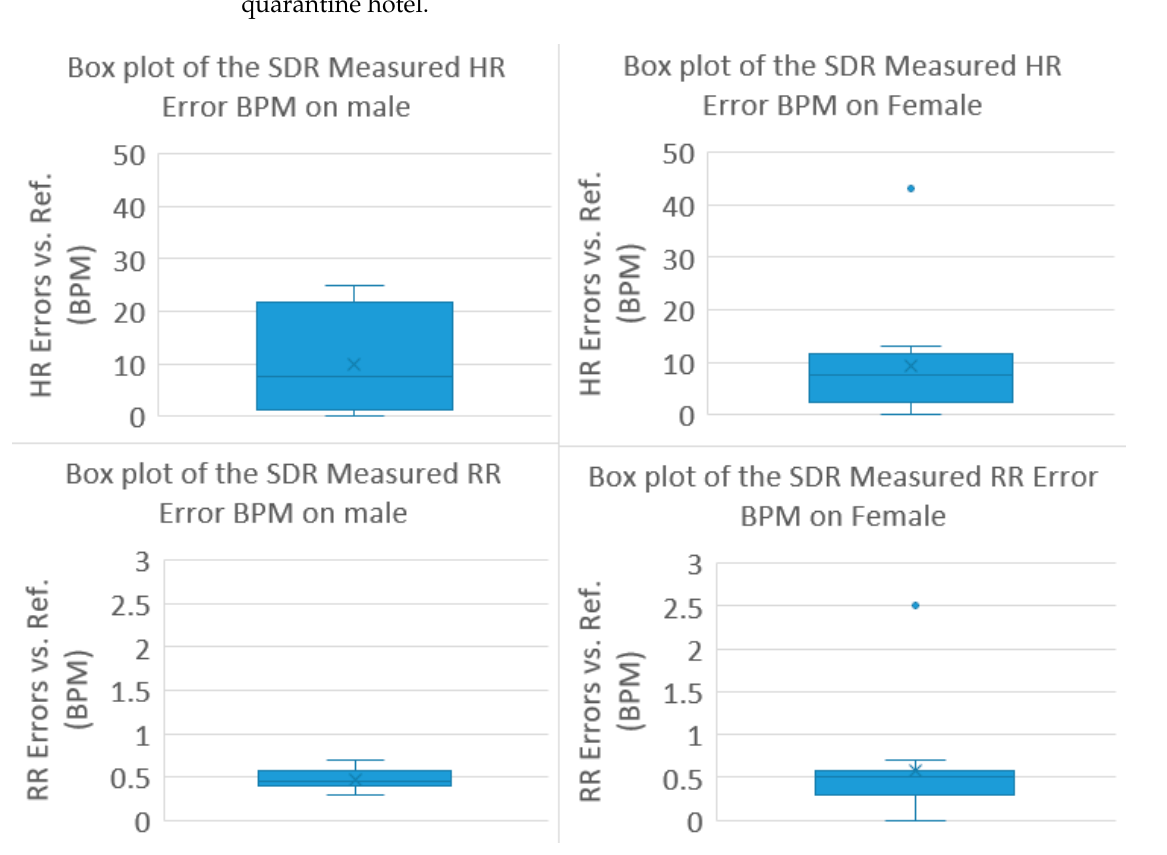
Figure 13. NCVS clinical trial test data from 20 cases as classified by gender.